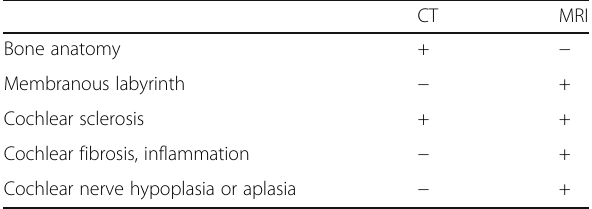
Table 2 Comparison of CT and MRI in imaging of various pre- operative